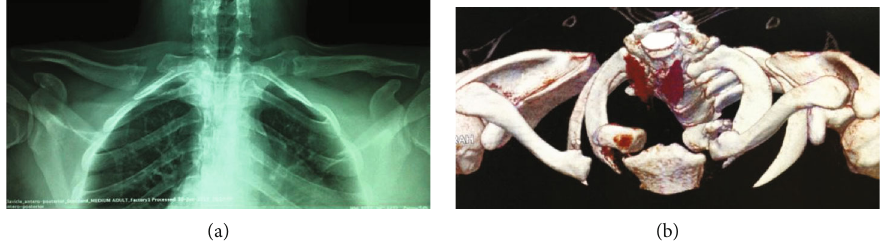
Figure 3: After two years follow up, (a) Anteroposterior radiograph of the clavicles revealing bilateral pseudoarthrosis. Incidence performed with a 40 ° head rays (serendipity incidence). (b) Computed tomography with three-dimensional reconstruction of the clavicles characterizing the